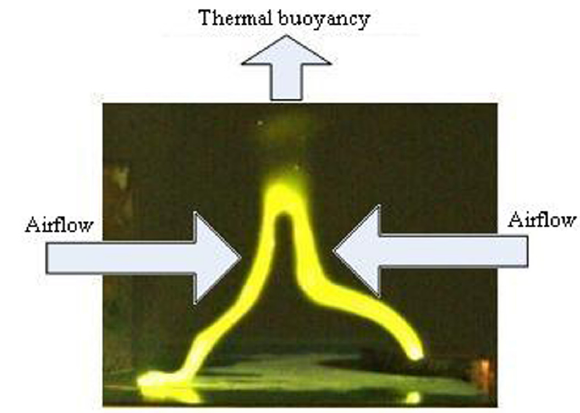
Figure 10. Schematic diagram of airflow caused by thermal